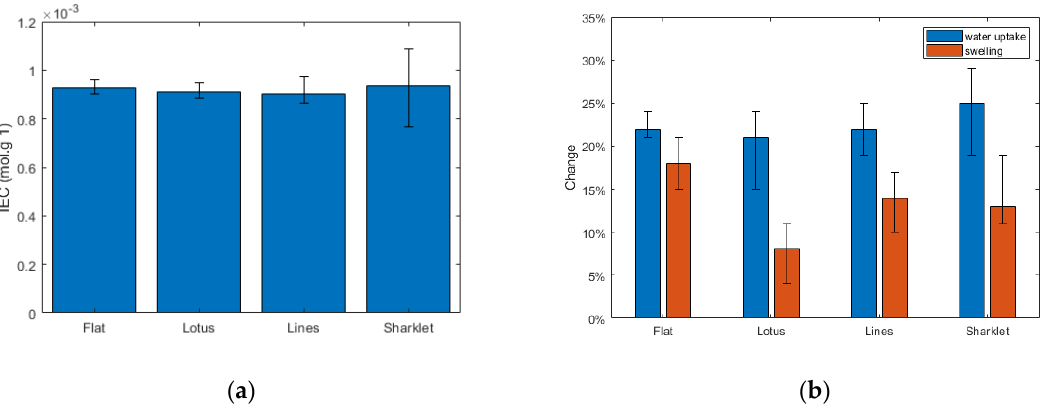
Figure 2. ( a ) Ion exchange capacity, ( b ) water uptake, and swelling ratio for the patterned membranes. Table 3 gives the membrane thicknesses for all the samples at dry and hydrated con ‐ ditions; the thicknesses are essential for understanding the relative hydrogen crossover from the patterns. Table 3. Average sample thickness, dried and hydrated.